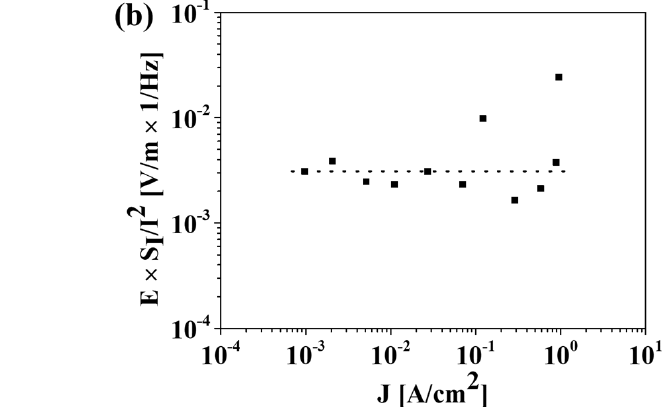
Figure 6. ( a ) Current power spectral density ( S I ) as a function of current density ( J ) at f = 10 Hz for the fabricated MFM capacitor. The dashed line indicates J 2 . ( b ) Oxide trap density ( N t ) versus voltage extracted from S I measurements. Figure 7. ( a ) ∆ (C (cid:3398) F) versus measurement frequency and ( b ) oxide trap density ( N t ) calculated using the ∆ (C (cid:3398) F slope) method and measured at 10 kHz. 4. Conclusions An HfO 2 -based MFM capacitor was fabricated and characterized using I–V and noise measurements. The device exhibited a constant of E × S I / I 2 noise values and noise shapes of 1/ f , indicating that the dominant transport mechanism is a trap-related PF emission caused by trapping in the oxide defects. The oxide trap density, N t , extracted from the noise measurements was as low as 1.6 × 10 20 cm − 3 ·eV − 1 . The important finding is that the transport mechanism of the MFM capacitor itself has no dependency on the polarization direction, whereas the asymmetric MFIS configuration has different mechanisms 10 -4